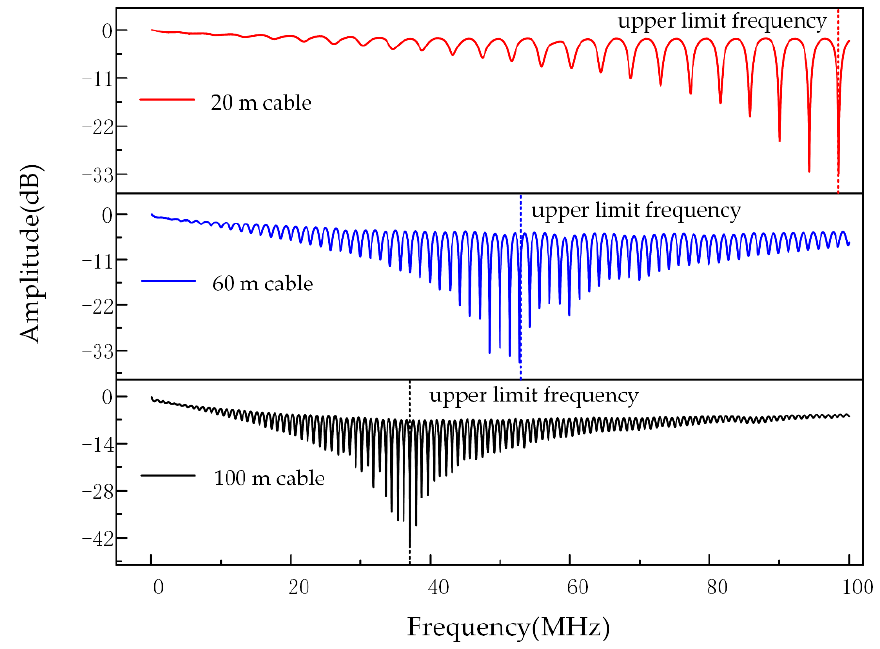
Figure 3. Upper limit frequencies of cables with different lengths.